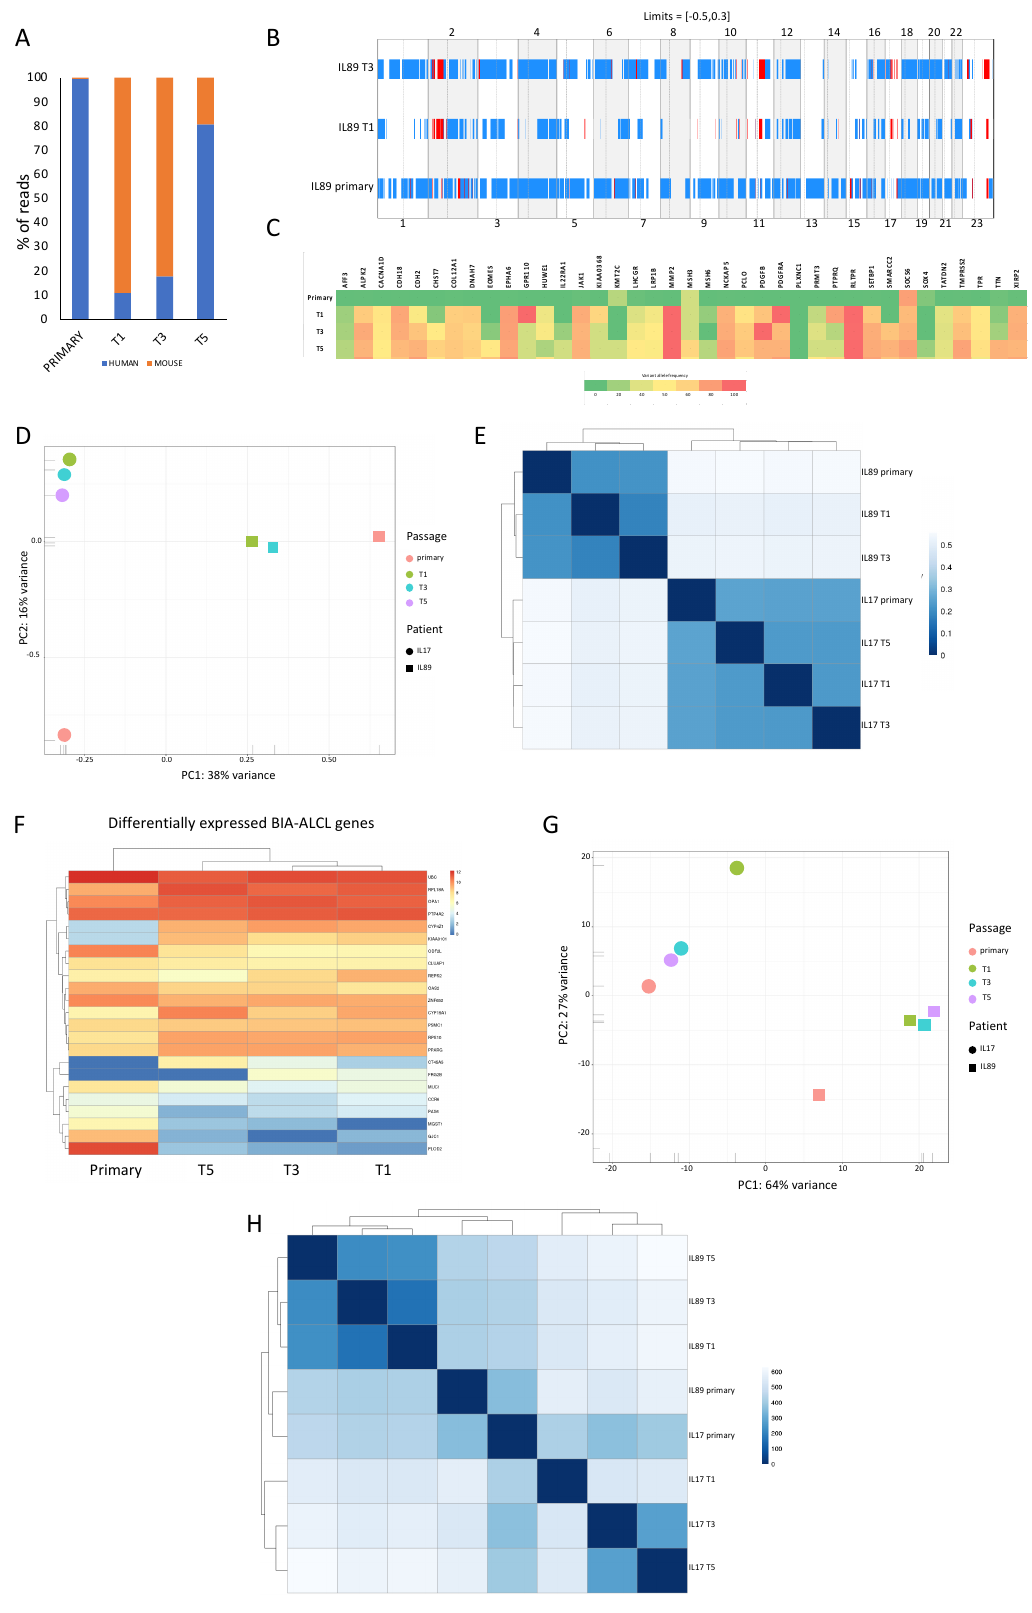
Figure 2. IL89 PDTX molecular landscape. ( A ) The percentage of PDTX human vs. mouse content was calculated by normalizing the number of reads from whole exome sequencing (WES) aligned with the human (hg19) or murine (mm10) genomes. Ambiguous reads were excluded from the analysis. ( B ) Copy number variations (CNV) analysis. Frequency of CNV (Y axis) according to chromosomal